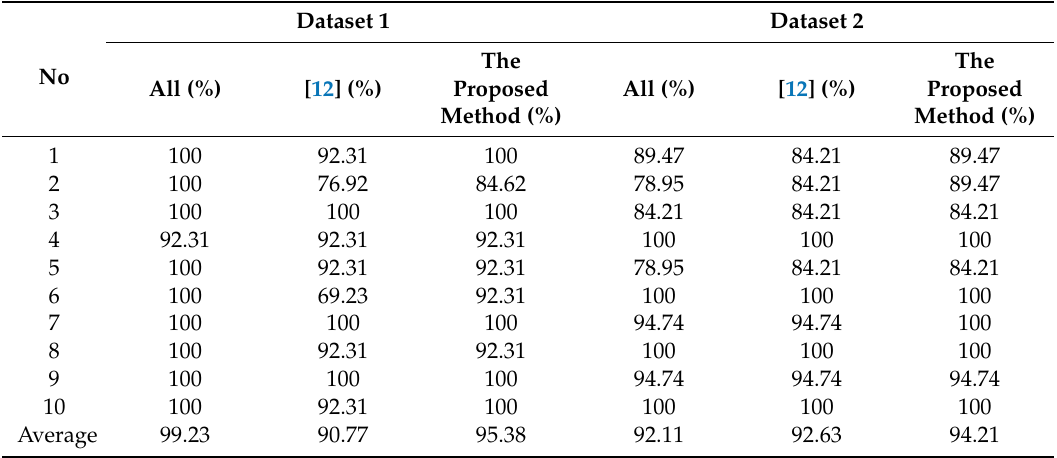
Table 6. The classification accuracy results (%) for 10-fold cross validation.